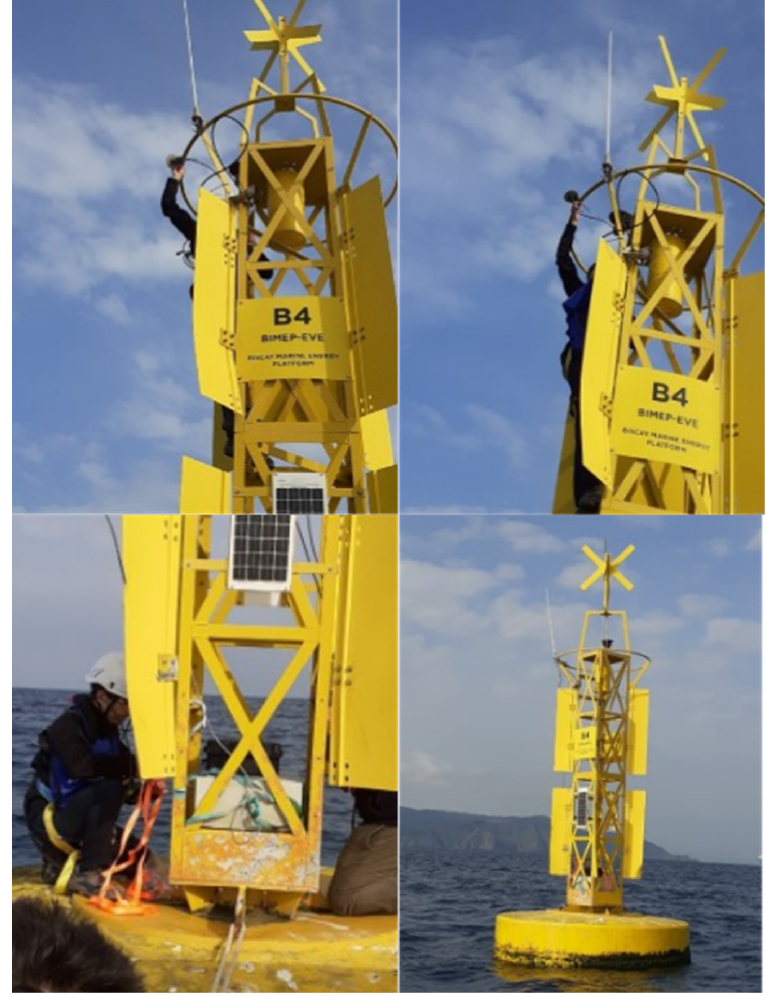
Figure 8. Smart sensor installation on the marking buoy.